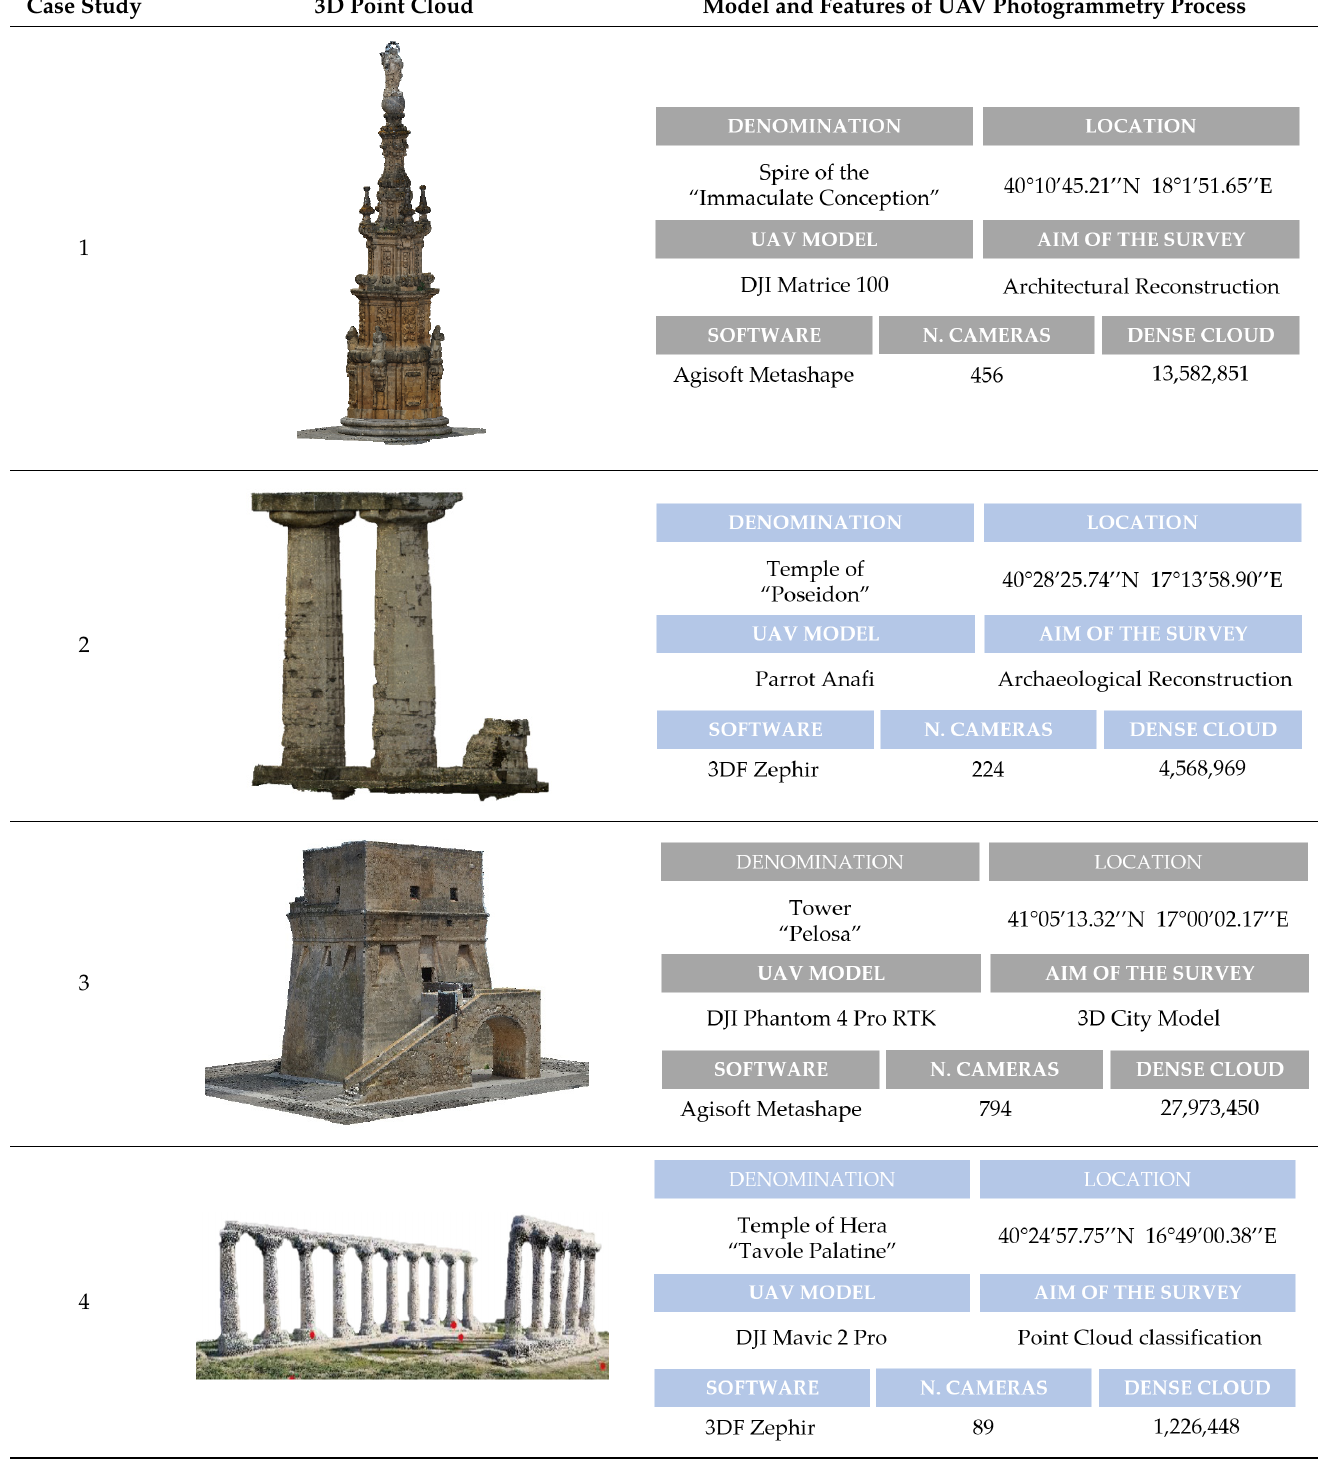
Table 9. Examples of UAV photogrammetry applications in the CH field.